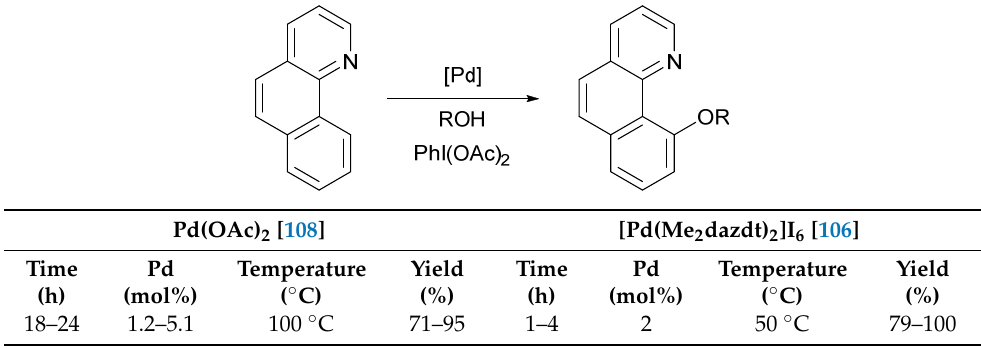
Table 3. Catalytic activity of recovery product [Pd(Me 2 dazdt) 2 ]I 6 vs. conventional [Pd(OAc) 2 ], Reproduced with permission from [106,108].